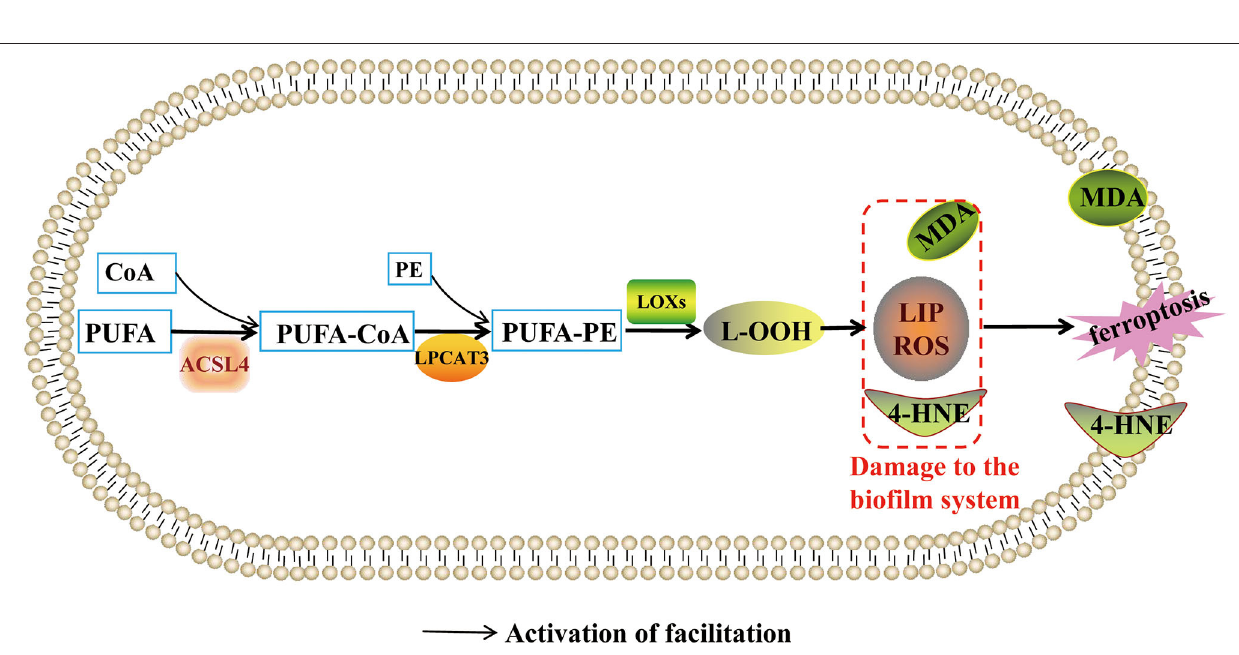
Frontiers in Public Health |